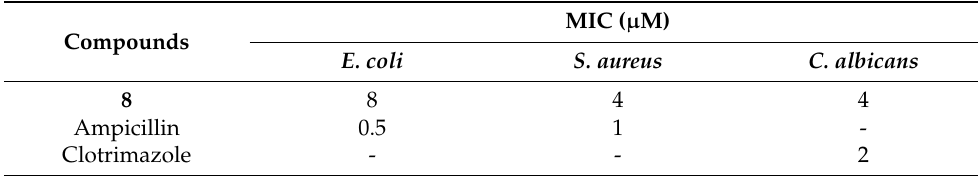
Table 3. The MIC of OSe compound 8 .